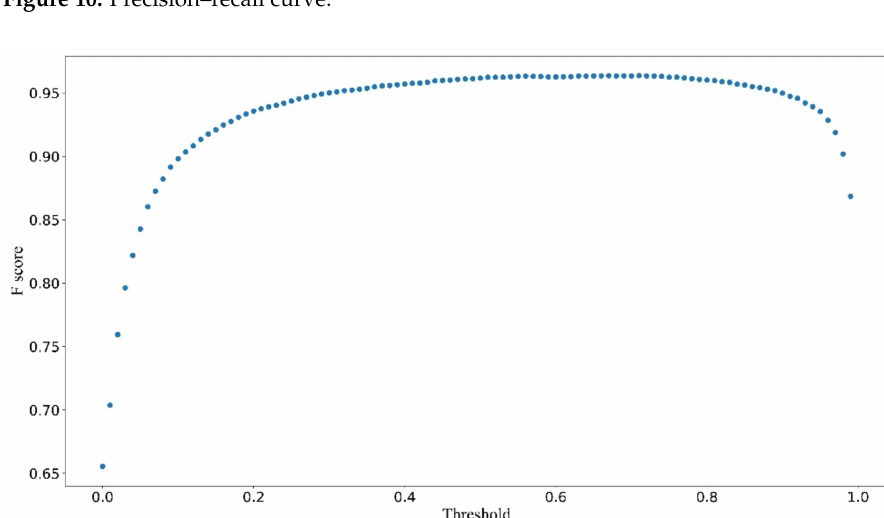
Figure 11. Threshold–F